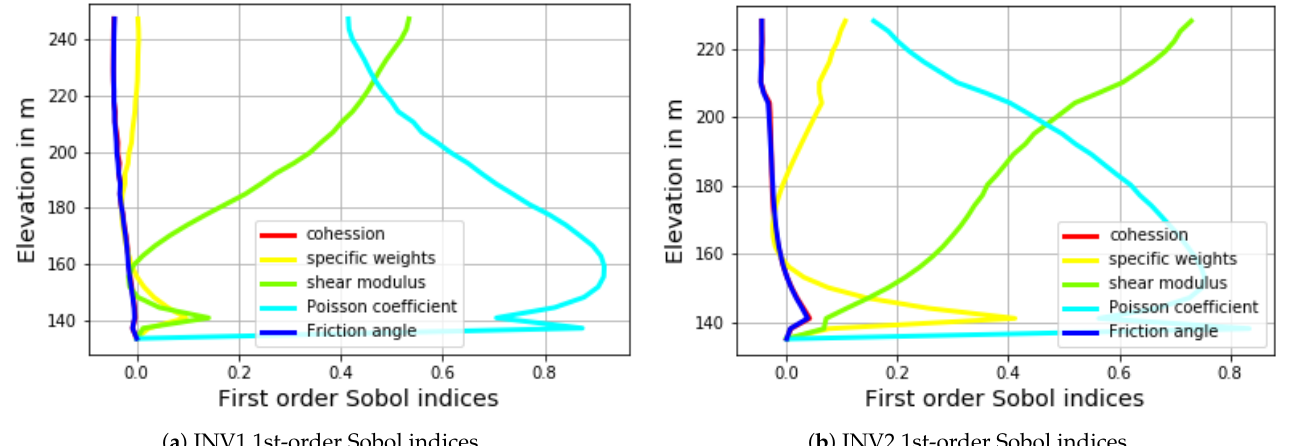
Figure 11. First Sobol index results obtained using PCE surrogate model.